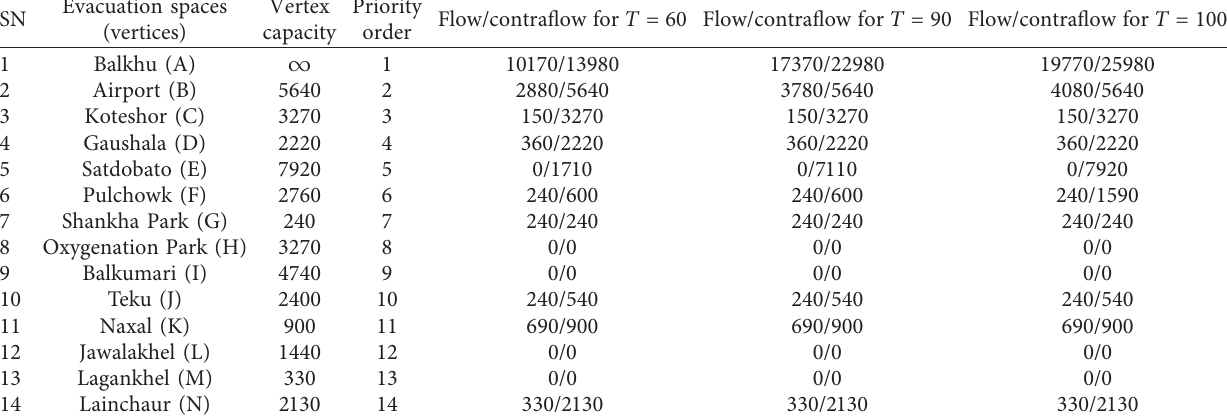
Table 1: Maximum flow values (evacuees) at sink (Balkhu) and intermediate vertices for Scenario I.